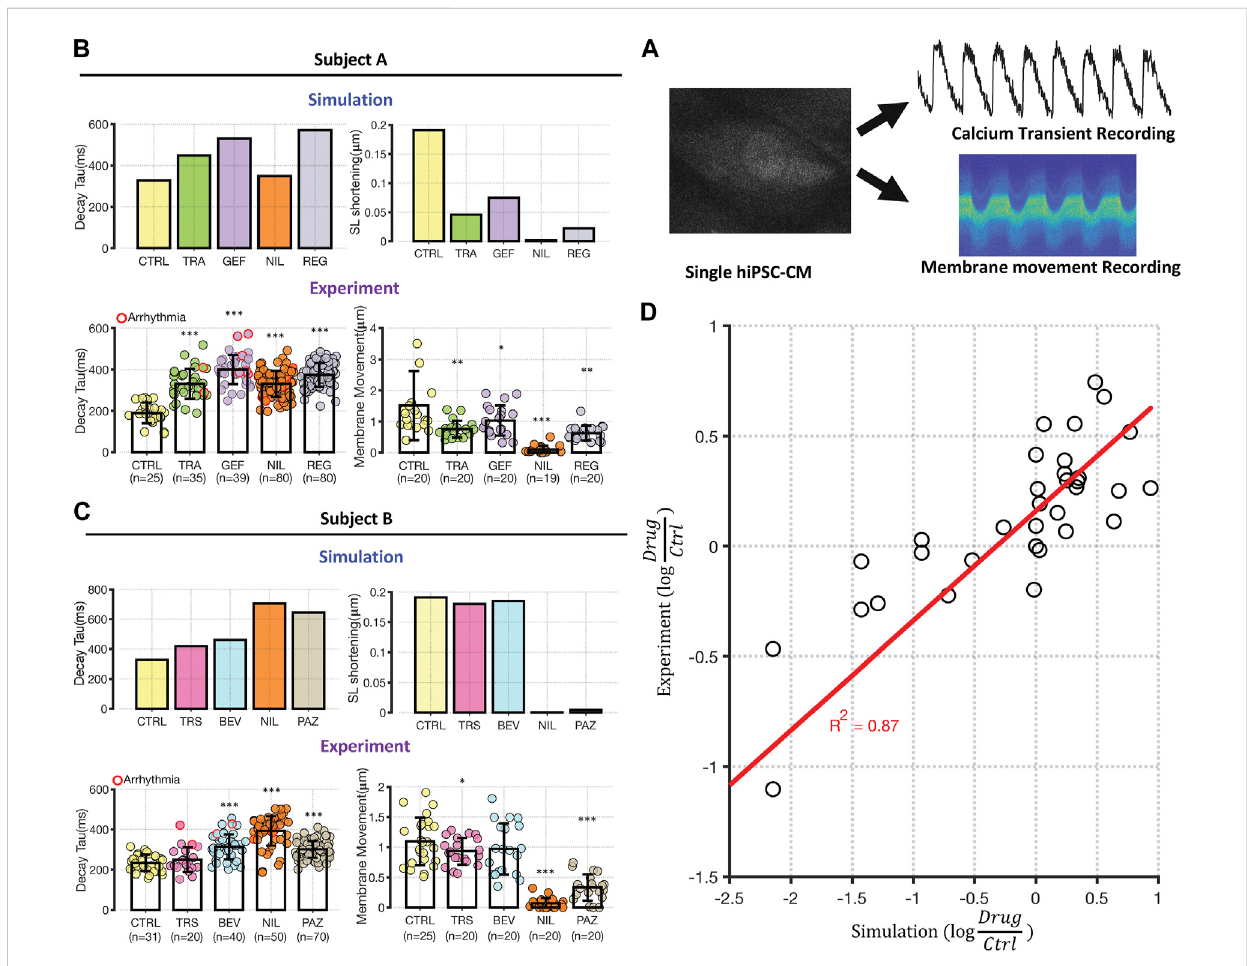
FIGURE 3 Experimental testing of transcriptomic based simulation predictions. (A) Schematic illustrating that iPSC-CMs were loaded with either fl uo3 or FluoVolt for CaT or membrane movement recordings, respectively. Metrics were extracted from fl uorescence time course measurements for comparison with simulation results. (B, C) Comparison between simulations of Decay Tau (left bar graphs) and SL shortening (right bar graphs) in the two cell lines. Simulationresults for control conditions and four drugs in each cell lineare shown above experimental results underthe sameconditions. Results from Cell Lines A and B are displayed in panels (B) and (C) , respectively. Error bars indicate standard deviation, and asterisks indicate signi fi cantly differentfromcontrol,based ontwo sample, unpaired t -test(* p < 0.05, ** p < 0.01 and *** p < 0.001). The number ofexperimentalsamples ineach group is provided beneath the experimental bar graphs. (D) Direct comparison of modeling predictions (abscissa) with experimental data (ordinate), with each expressed as the logarithm of the change in drug-treated relative to vehicle-treated iPSC-CMs. Each dot represents a change in a time course metric (DecayTau,CaTtriangulation,CaTAUC,andSLshortening)causedbychangesingeneexpressioninducedbyaparticulardrugs.ResultsfromCellLinesA and B are grouped together, and thecalculated R 2 of 0.87 includes 3 data points that induce extreme changes to metrics and are not visible on this